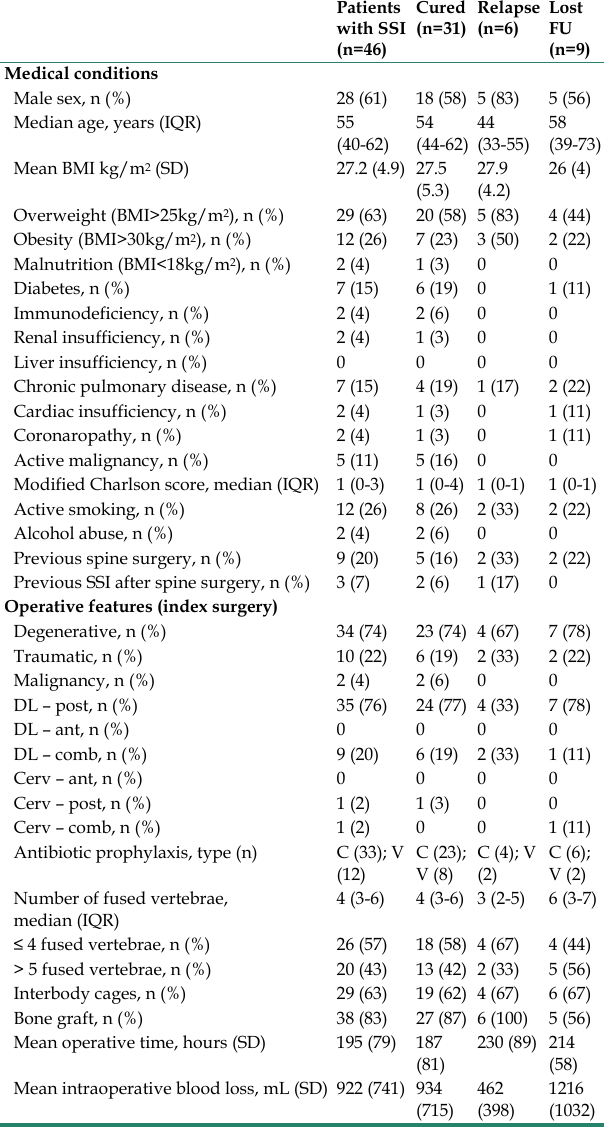
Table 2. Patient and surgical characteristics